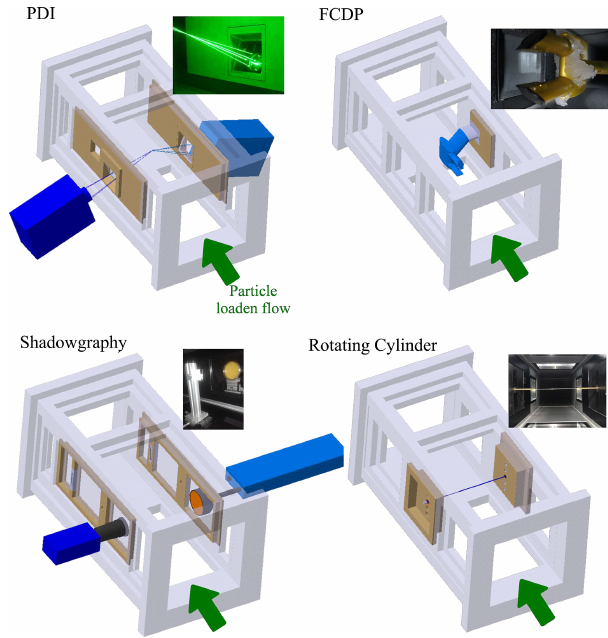
Figure 7. Measurement setups in the Braunschweig Icing Wind